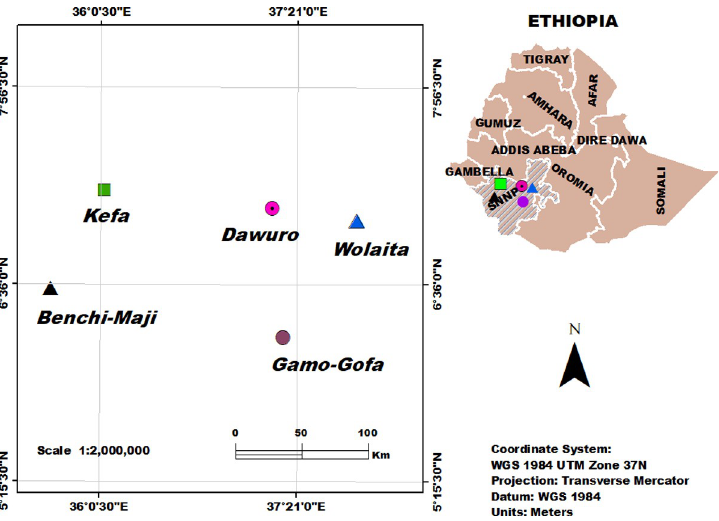
Fig 1. Map showing administrative zones where the cocoyam accessions were collected. The map was prepared with ArcGIS Desktop (ArcGIS Desktop 10.2.2. Esri).